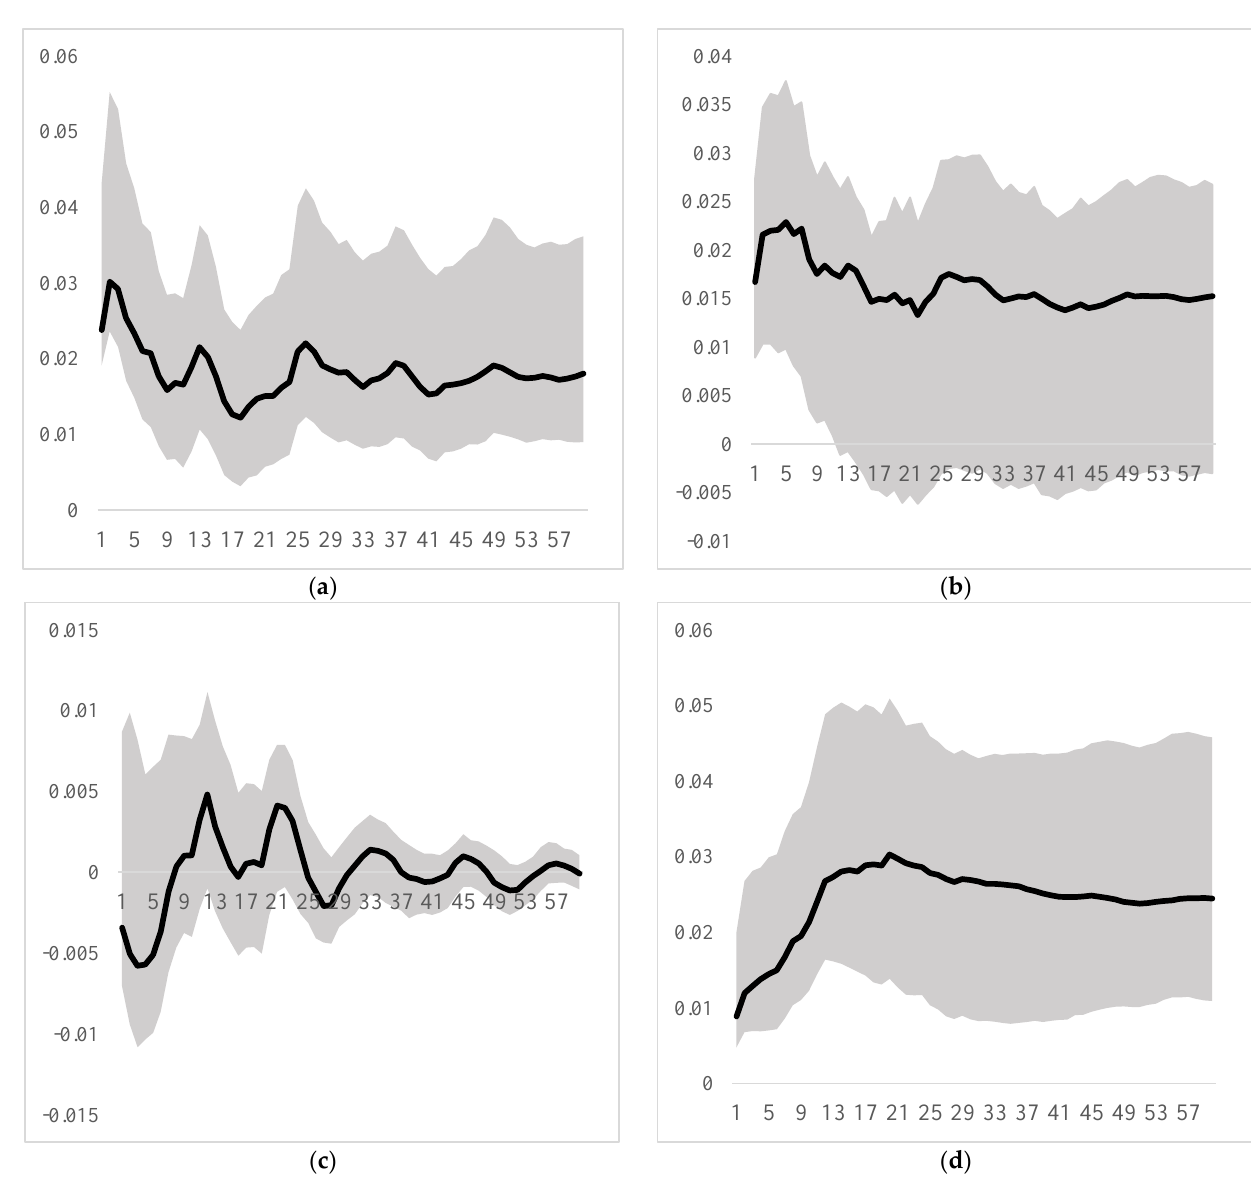
Figure 3. Accumulated structural impulse response functions. Source: authors’ estimation. Note: The shaded area indicates 95% confidence interval from bootstrap simulation with 500 replications. The shocks are the monthly positive one standard deviation. Horizontal axis is in months. ( a ) Real exchange rate to real shock; ( b ) nominal exchange rate to real shock; ( c ) real exchange rate to nominal shock; ( d ) nominal exchange rate to nominal shock.